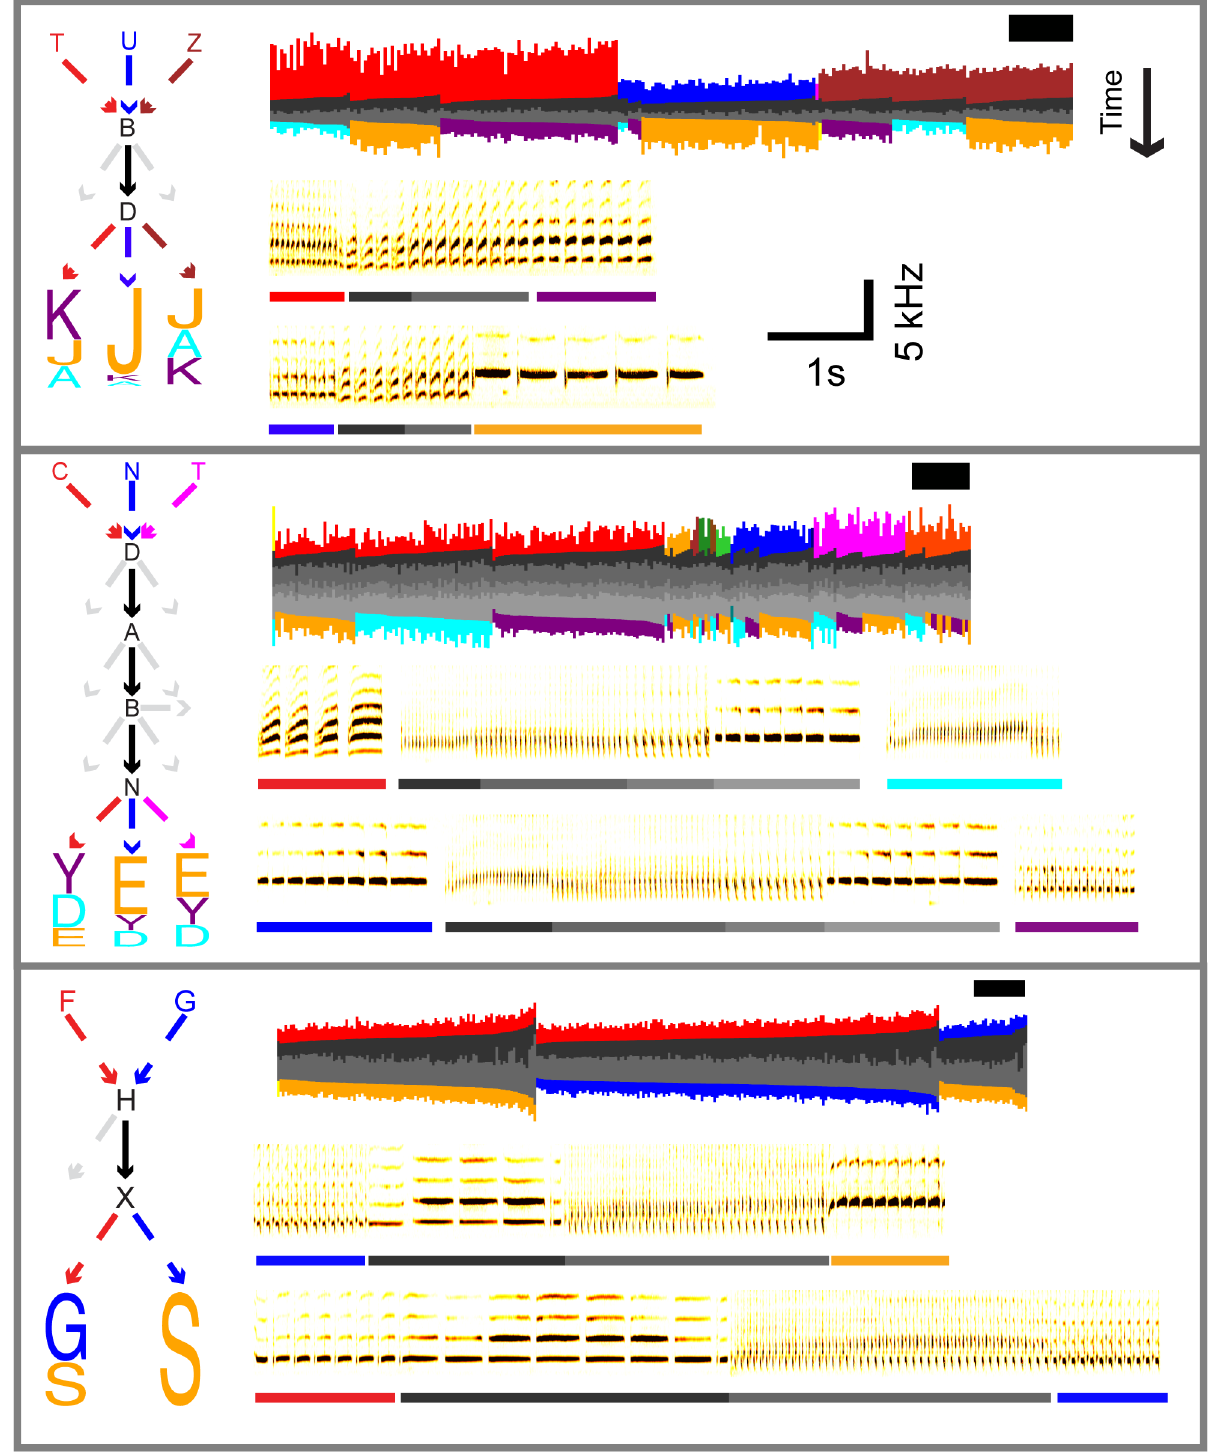
Figure 7. Decisions at branch points in song can impact syllable transition probabilities 5 phrases later. Each panel corresponds to a different bird. For a given panel, the colors in each part of the panel signify the same syllables. Left: letters (arbitrarily chosen for each bird) indicate a single phrase type, and arrows indicate phrase transitions. Entry and exit paths are color-coded and the exit paths are sorted and scaled by their transition probability. For instance, on the far left, if the bird sings T R B R D, then K is most likely to follow, whereas a J would most likely follow if he sang U R B R D. The light dotted arrows indicate other possible paths of exiting a block with p . .05. For these other paths, the destination syllable is not shown. Actual transition probabilities with 95% bootstrap confidence intervals, and the number of transitions are given in Table S4 . Top right : song barcodes illustrate this effect for all occurrences of the phrase-block analyzed on the left. A square flanks each barcode to indicate the scale, with the height corresponding to 2 seconds and the width to 20 trials. Barcodes of the full song sequences are given in Fig. S6. Bottom right: example sonograms provide examples of how the entry path to a block of phrases changes the exit path.